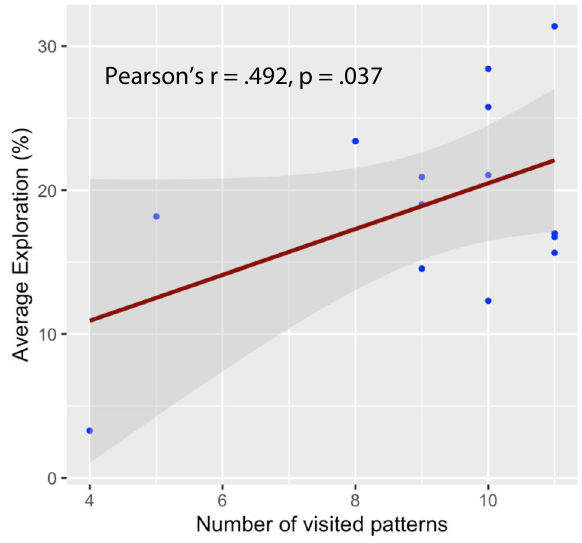
Figure 6. Relationship between emerging patterns and exploration. Significant correlation between the number of different patterns visited and the amount of exploration, the higher the number of different patterns the higher the amount of